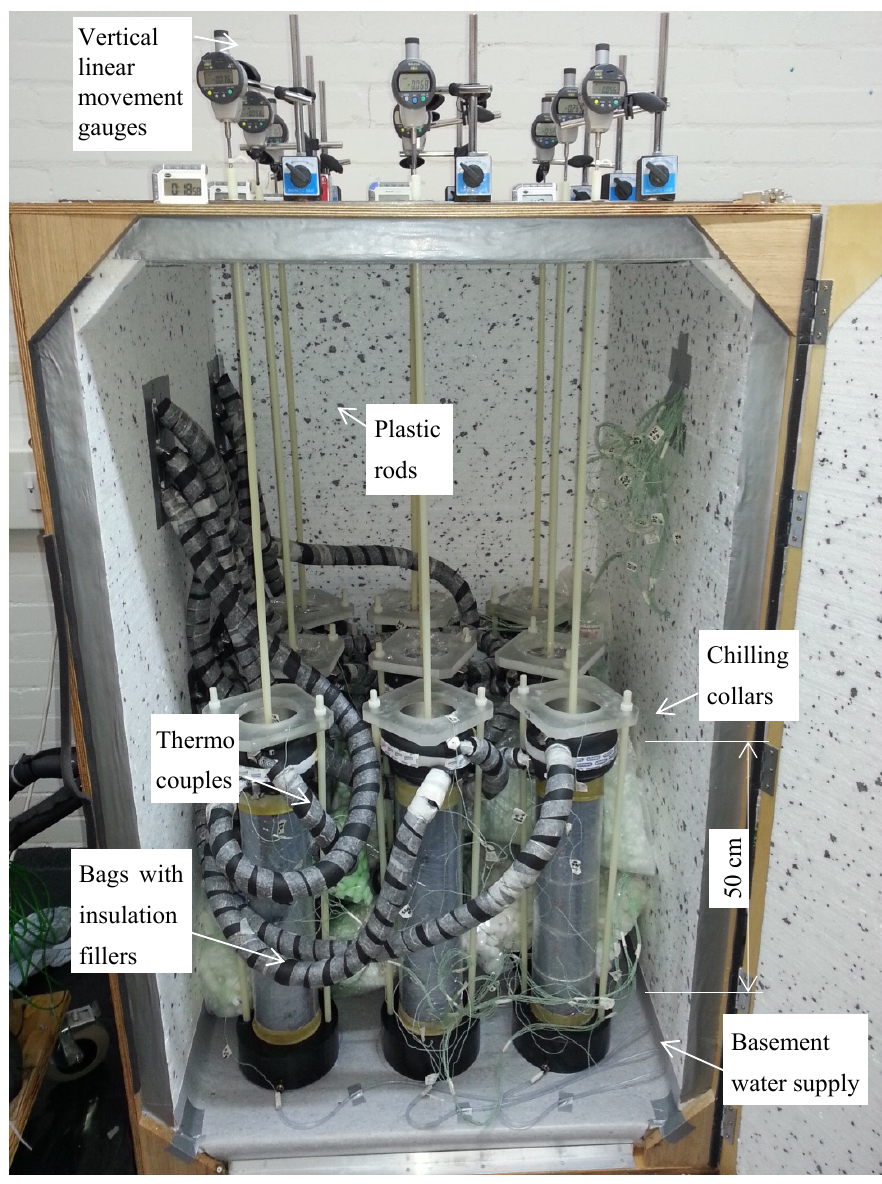
Figure 1. The open system experimental setup used to investigate freeze–thaw cycles in soil col- umns.